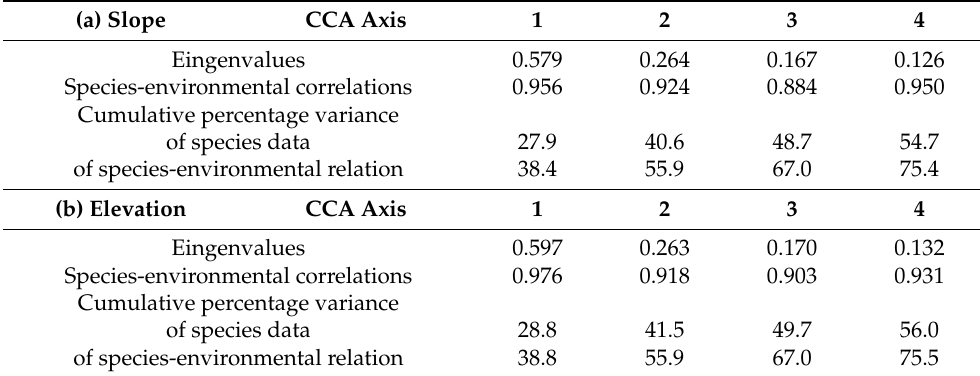
Table 4. Summary statistics table for CCA ordination presented, with slope ( a ) or elevation ( b ) as key